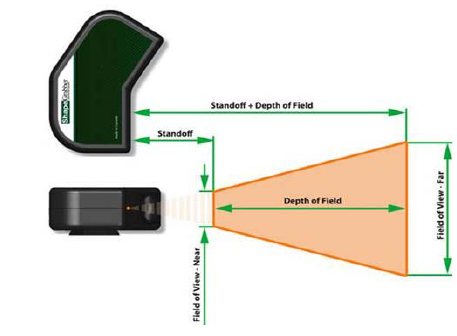
Figure 4. ShapeGrapper head parameters.